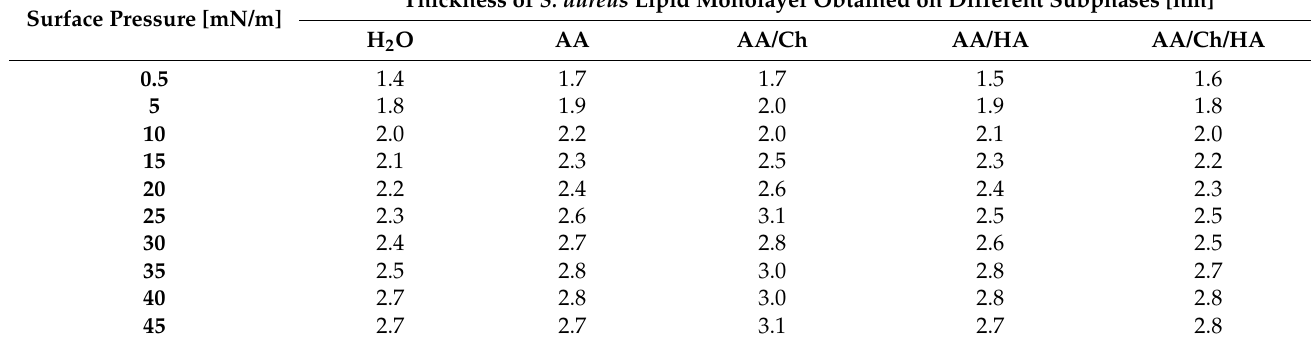
Table 3. Thickness of the S. aureus lipid monolayers during